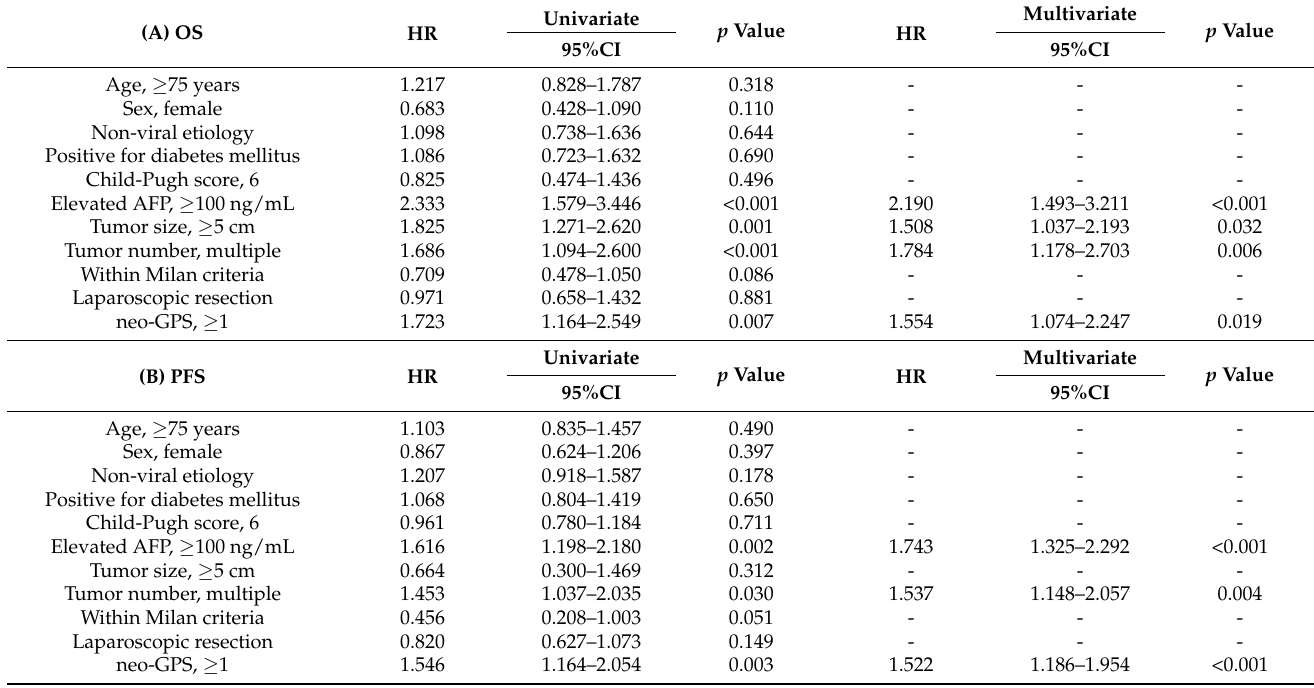
Table 2. Cox hazard analysis for overall survival and progression-free